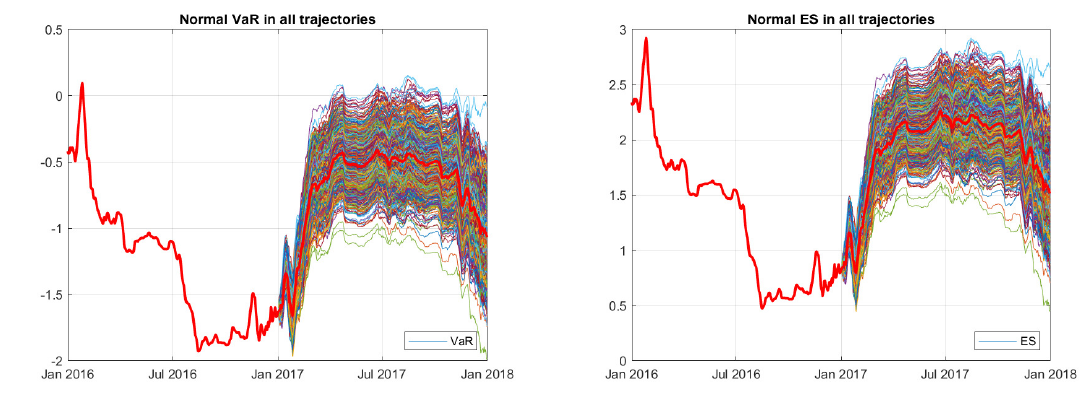
Figure11. SimulatedVaRandESfor2017applyingin1000di ff erenttrajectoriesusingthenormalmethod.